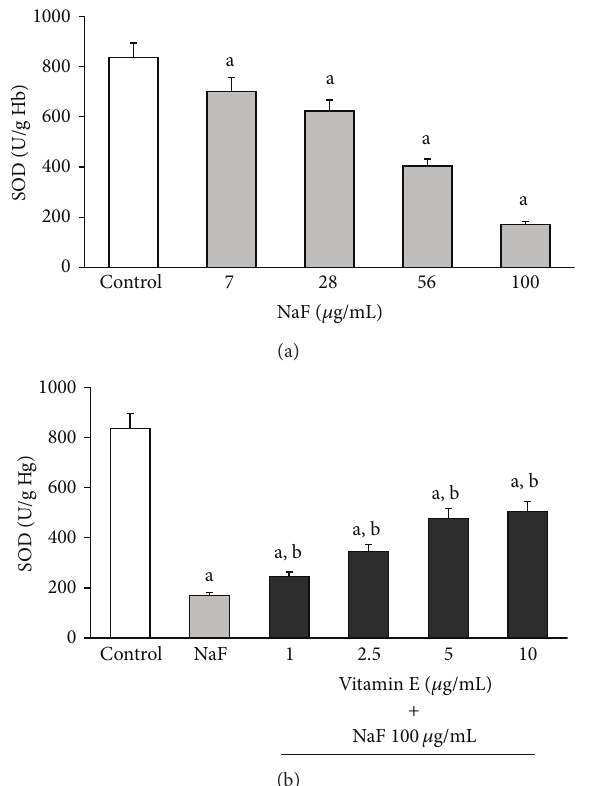
Figure 3: CAT activity in erythrocytes incubated under the same conditions described in Figure 2. The results are expressed as the mean ± standard deviation of five independent experiments, taking two samples per experiment and performing the determinations in triplicate. a 𝑃 < 0.05 compared with the control group; b 𝑃 < 0.05 compared with the group incubated with only 100 𝜇 g/mL